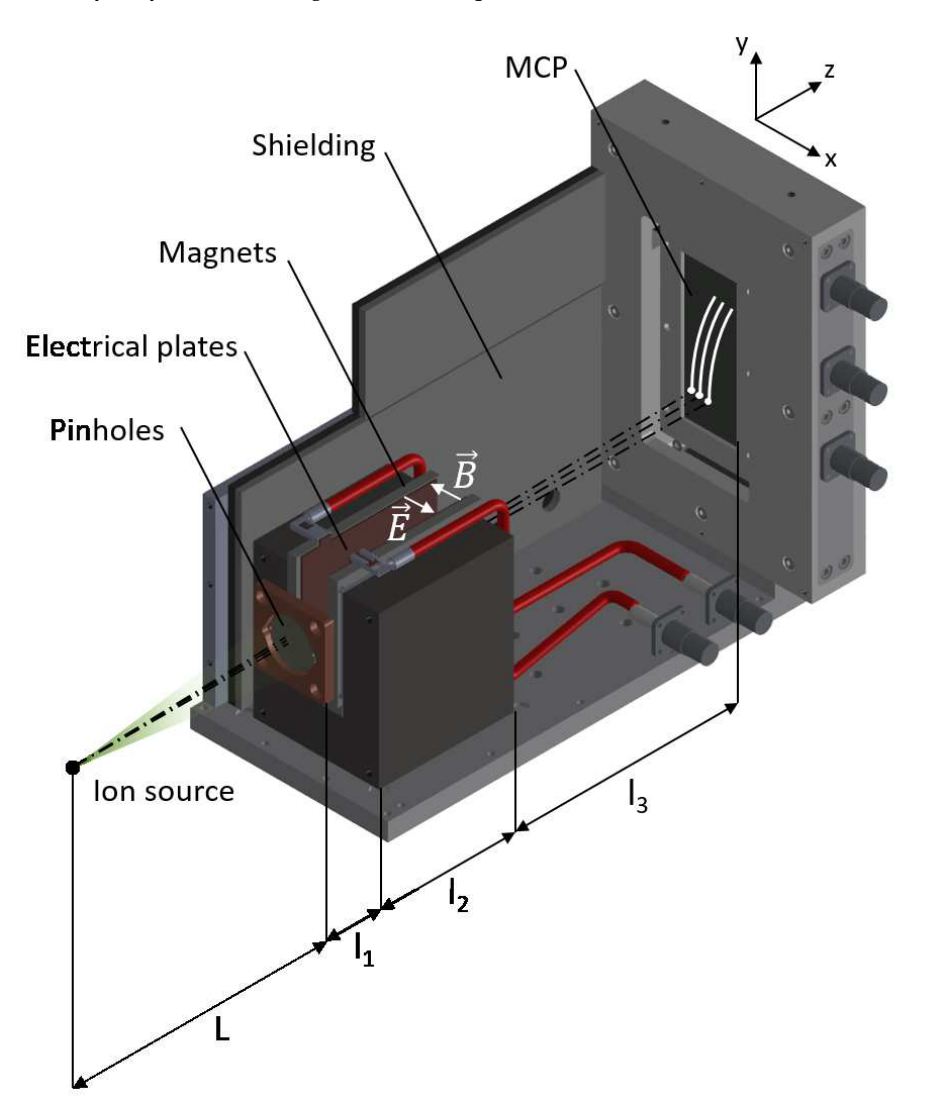
Figure 1. Multi-pinhole TP spectrometer